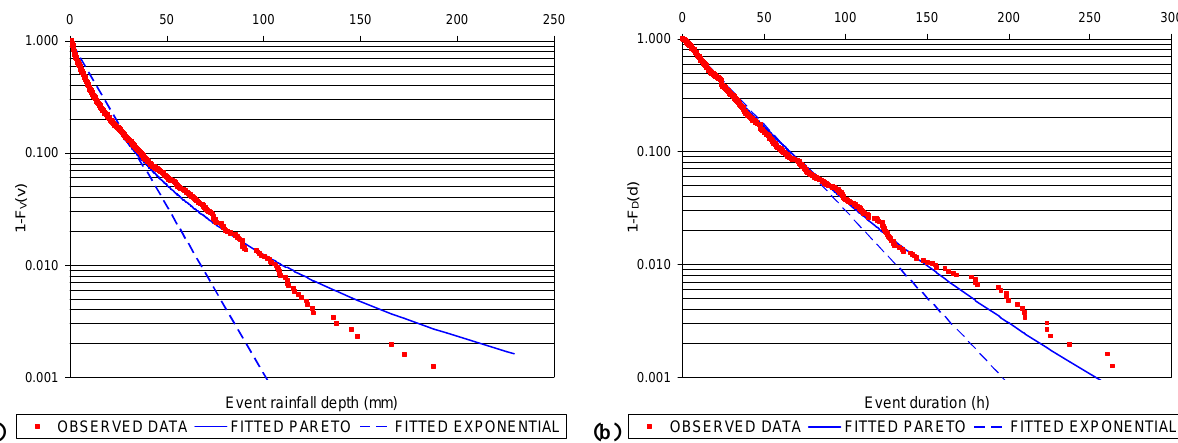
Fig. 6. Exponential and alternative probability distributions for rainfall event depth and duration (Valencia raingauge).